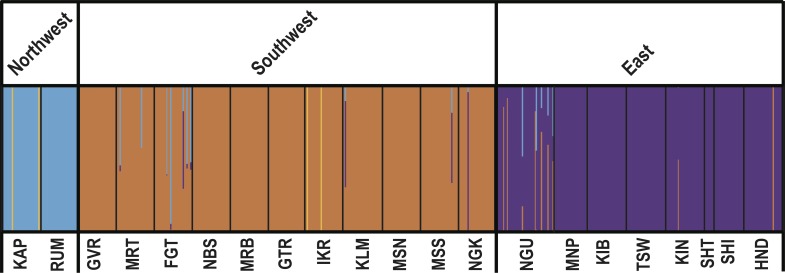
Results of the Bayesian clustering analyses based on microsatellite data.Spatially explicit genetic clustering was performed in the program BAPS v 6 [55,56] Vertical bars indicate the probability of assignment (q-value) of an individual to each cluster (S7 Table). Thin vertical lines separate sampling sites reported along the bottom x-axis, and think vertical lines separate the three major clusters reported along the top x-axis.